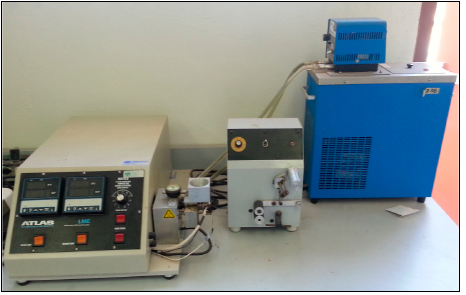
Figure 4. Image of the extruder used in the preparation of the films. Table 4. Concentration of each component used in the preparation of PP/chitosan composites.